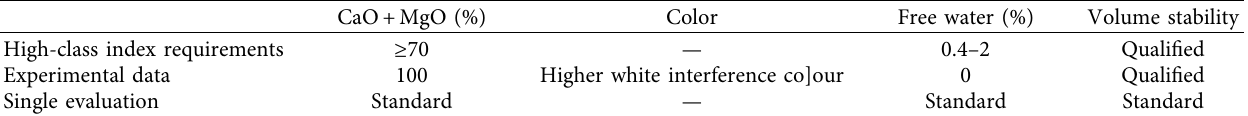
Table 6: Marble powder